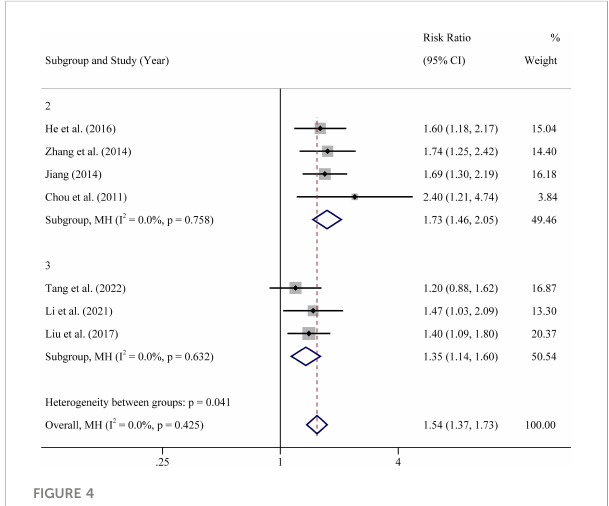
FIGURE 4 Subgroup analysis based on RIF diagnostic criteria of clinical pregnancy rate.